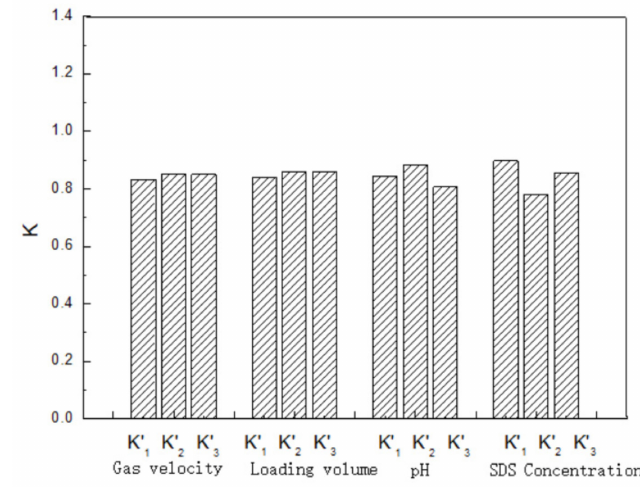
Figure 7. K value distribution of enrichment ratio E.